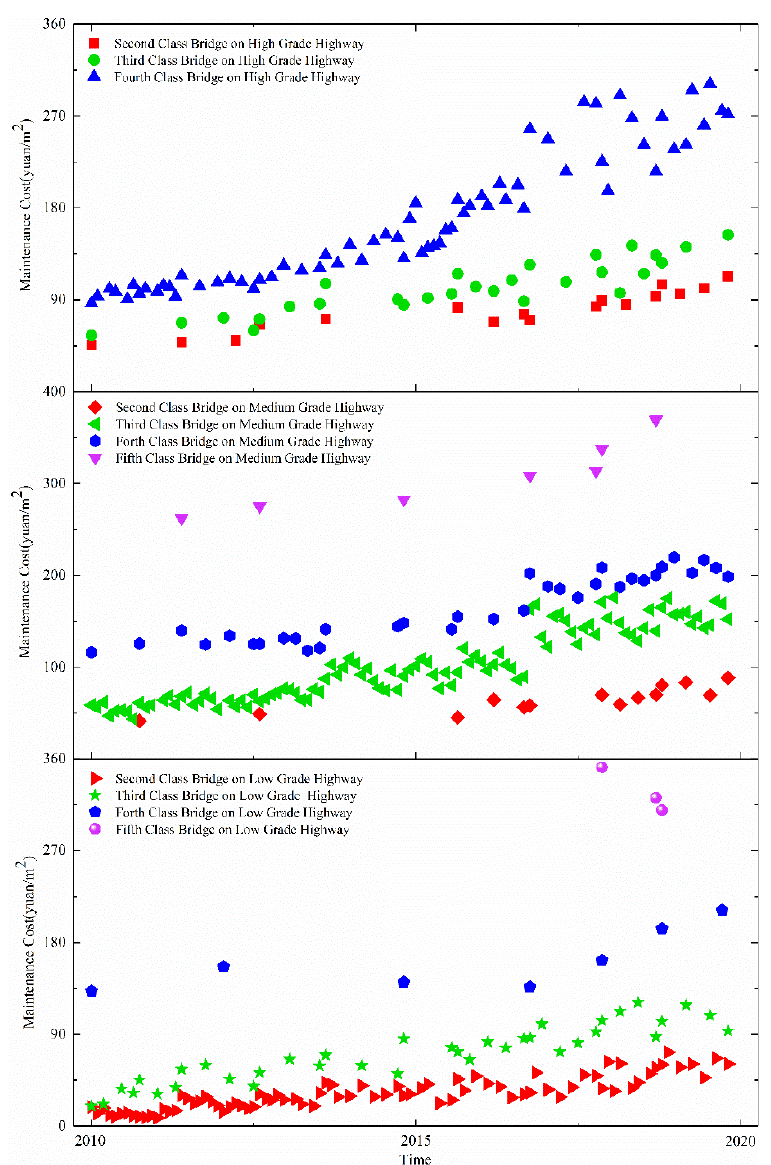
Figure 10. Sample classification diagram after data screening and replacement. Table 4. Classification of the